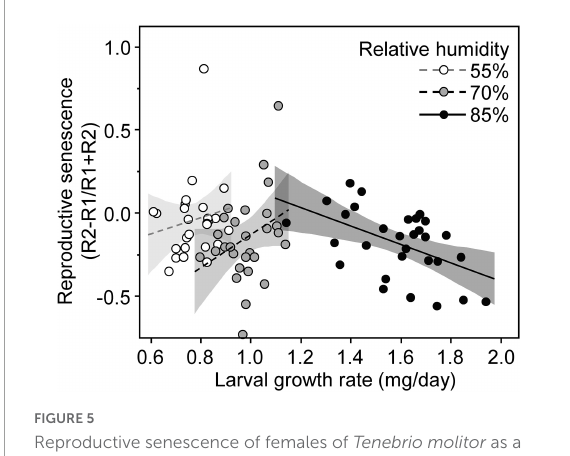
FIGURE5 Reproductive senescence of females of Tenebrio molitor as a function of larval growth rate and according to the conditions of larval growth (relative humidity). Reproductive senescence was estimated by the difference between the late number of eggs (R2) and the early number of eggs (R1) corrected by the total number of eggs during the two reproductive episodes (R1 +